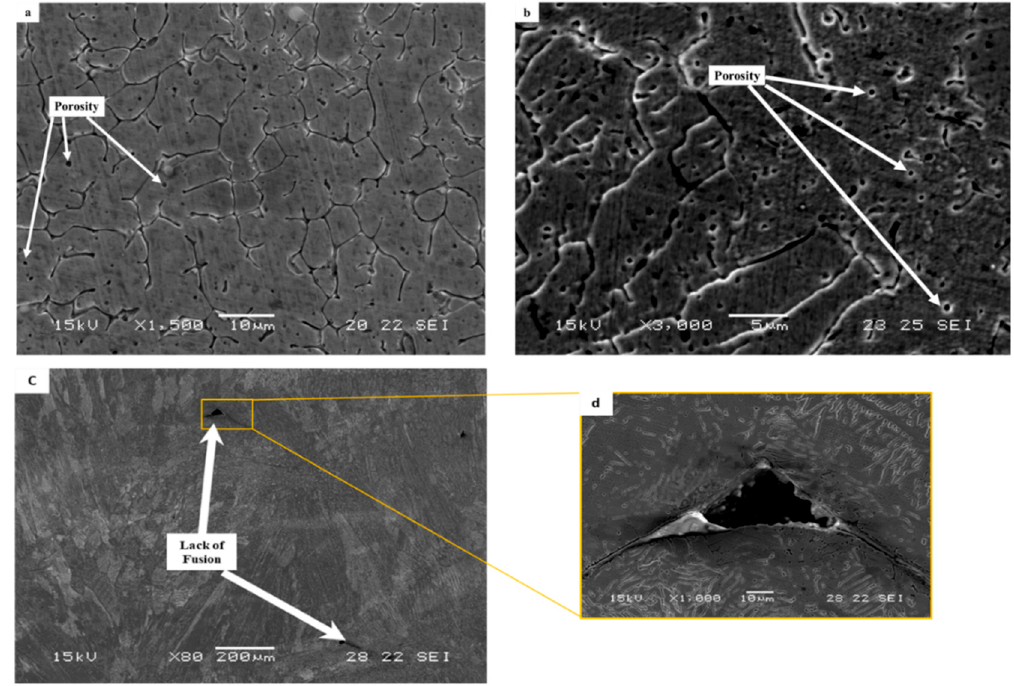
Figure 4. Typical microstructural imperfections in WLAM 316L samples: ( a , b ) porosity in the XY plane and XZ plane, respectively, and ( c , d ) lack of fusion.